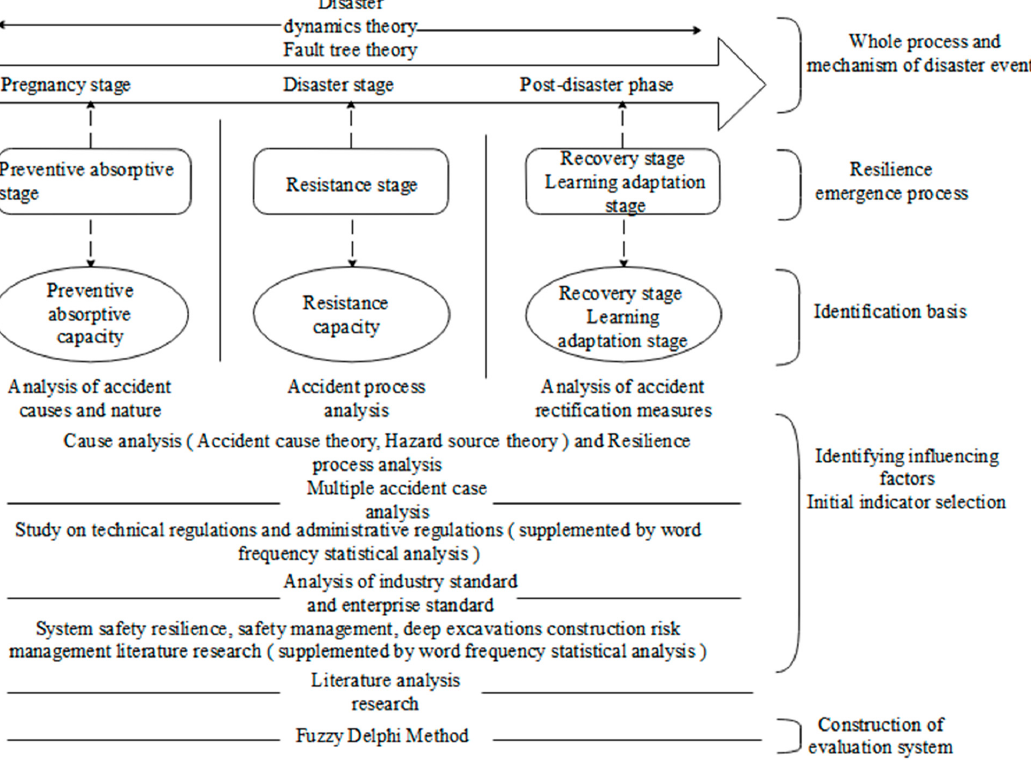
Figure 2. Construction process of resilience evaluation index system.